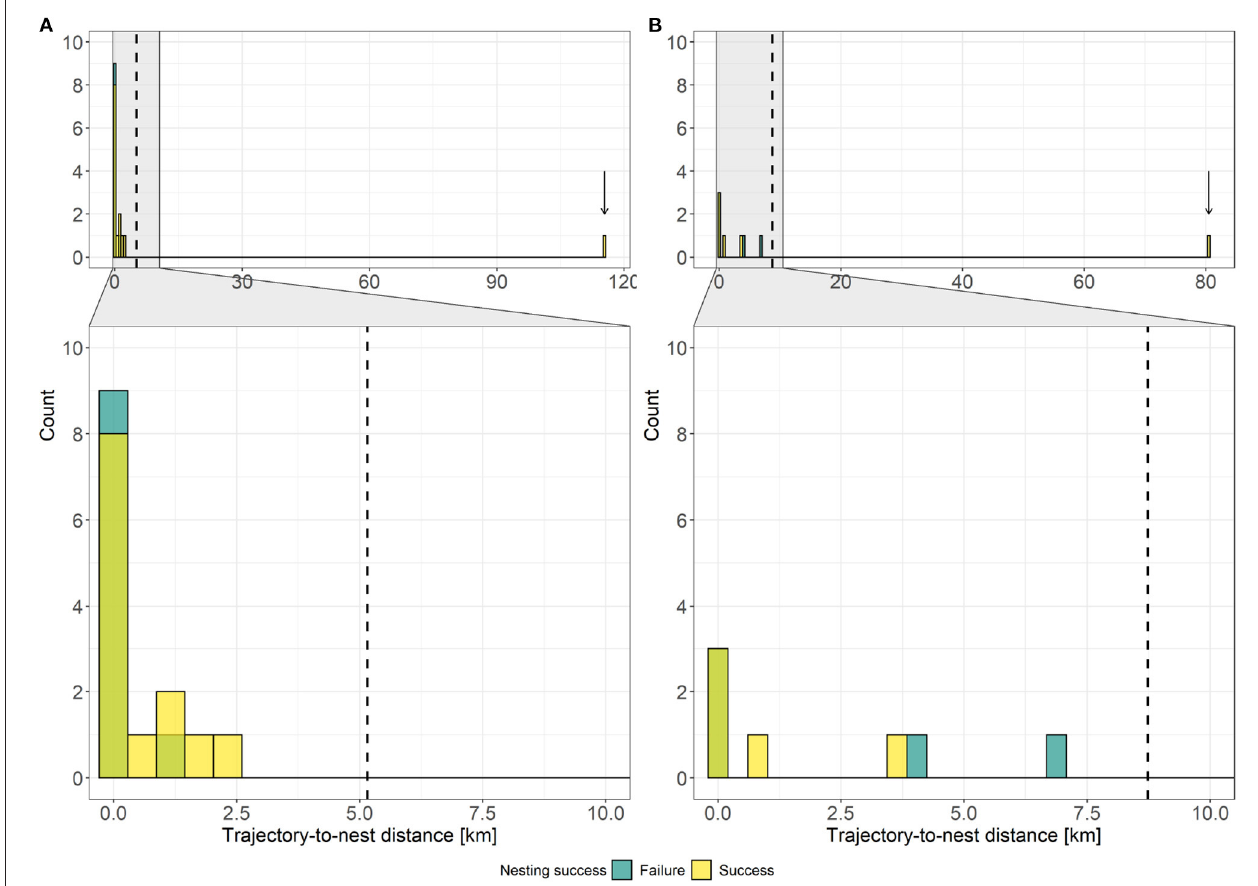
FIGURE 6 | Histogram of the minimum distance between the trajectory of the current year and nest location of the following year (trajectory-to-nest distance) for (A) stable and (B) variable resources. Dashed line represents the mean value.